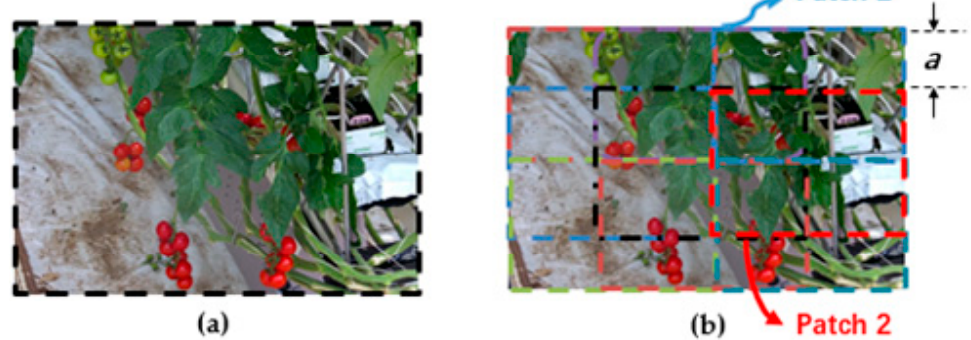
Figure 9. Word document encoding based on an improved document partition. ( a ) The traditional LDA document construction regards the whole image as a single document; ( b ) Overlapping rectangular patches are adopted with interval a to construct documents, where a = 25 pixel.